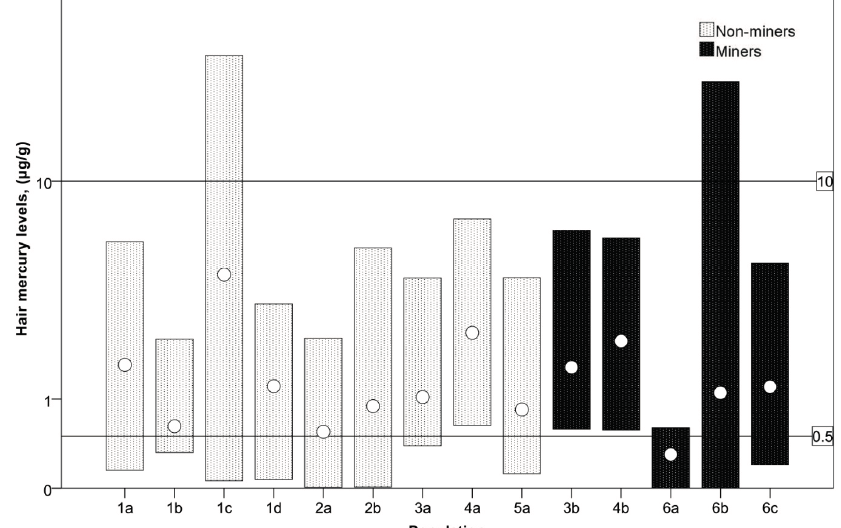
Figure 5. Mercury levels (µg/g) in hair samples of miners and non-miners from across Ghana. For a given population (see key below), the bars represent the measured range while the circles represent the mean. Lines represent the WHO guideline value of 10 μ g/g for mercury in hair [40], and 0.5 μ g/g, the average mercury concentration in hair for the U.S. population [38]. Study Population 1—Ankroba and Tano River Basins, Western Region [39]: 1a–d. Mining area residents, possibly involved in mining ( n = 50, 50, 51, 66, respectively). Study Population 2—Accra, Greater Accra Region, and Kumasi, Ashanti Region [43]: 2a. Students from Accra; 2b. Students from Kumasi ( n = 19, 18, respectively). Study Population 3—Pra River Basin (in Western, Central, and Ashanti Regions) [41]: 3a. Non-miners in mining area ( n = 24); 3b. Small-scale miners ( n =